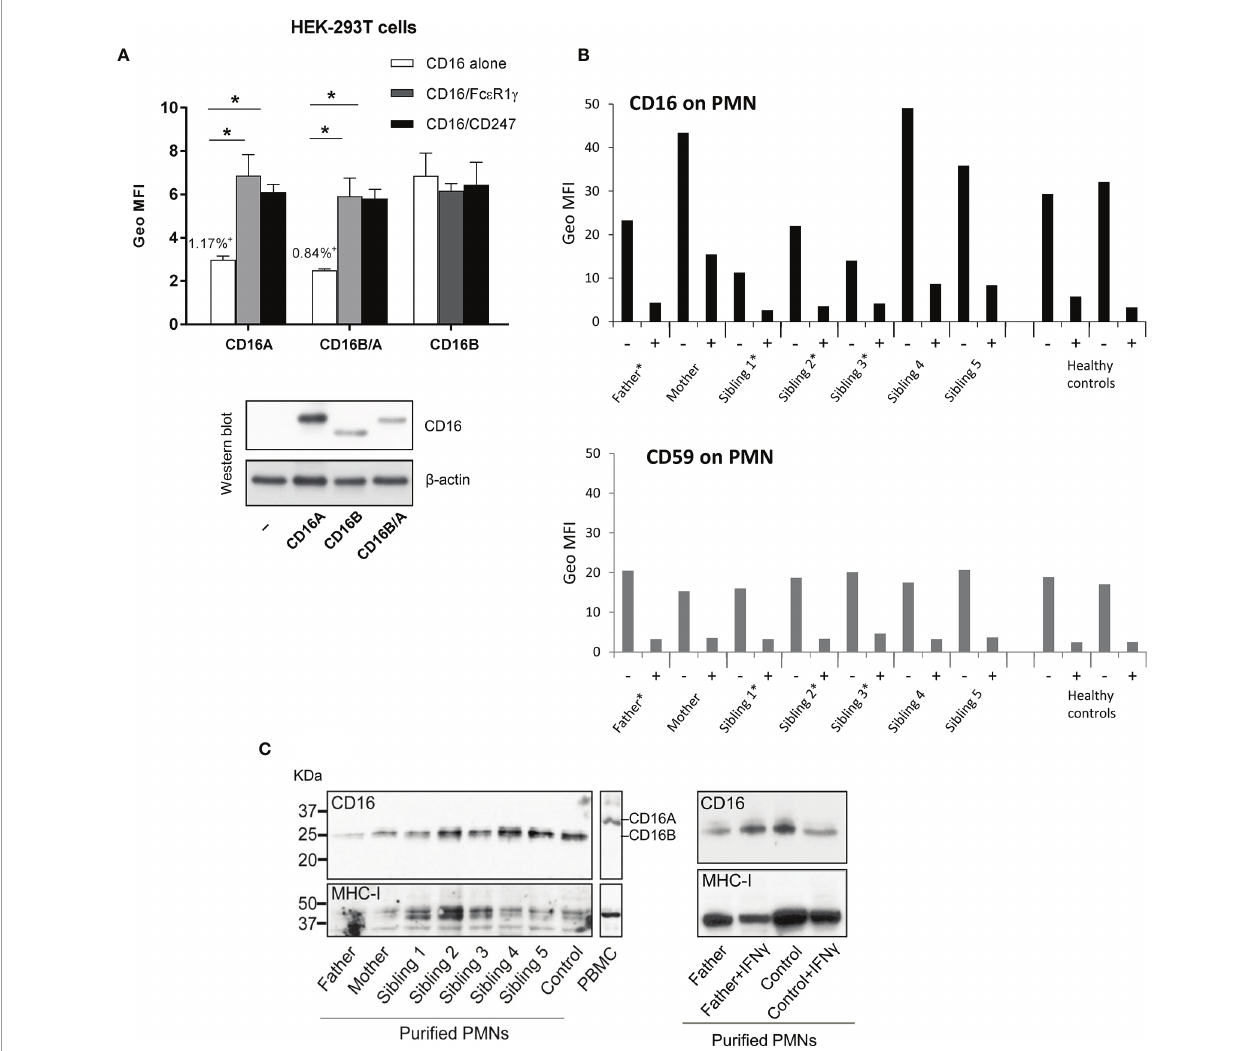
FIGURE 2 | CD16B/A expression on polymorphonuclear and HEK-293T cells. (A) The transmembrane CD16BA receptor must associate with Fc ϵ R1 g or CD247 for cell surface expression. HEK-293T cells were transfected with plasmids driving the expression of the indicated receptors and adaptor molecules and cell surface expression of CD16 was determined by fl ow cytometry and western blot. In all cases, more than 40% of the transfected cells expressed CD16 on the cell surface except for those cells transfected with CD16A or CD16B/A alone where CD16 staining was detected on only 1.17% and 0.84% of the cells, respectively. (B) No evidence for expression of a PI-PLC resistant form of CD16 on granulocytes of controls or family members. Freshly isolated granulocytes were mock digested, or PI- PLC treated, for 1hr at 37°C and then CD16 expression was analysed by fl ow cytometry. Asterisks mark FCGR3B/A carriers. (C) Western blot analysis of granulocyte lysates shows that the CD16 molecules present have a molecular weight typical of GPI-linked CD16B. Freshly isolated granulocytes were lysed and CD16 expression analysed, after treatment with PNGase, by western blot. On the right side, analyses of fresh and IFN g -stimulated polymorphonuclear cells isolated from blood of a CNR5 carrier (father) and a normal control donor do not reveal induction of a FCGR3B/A